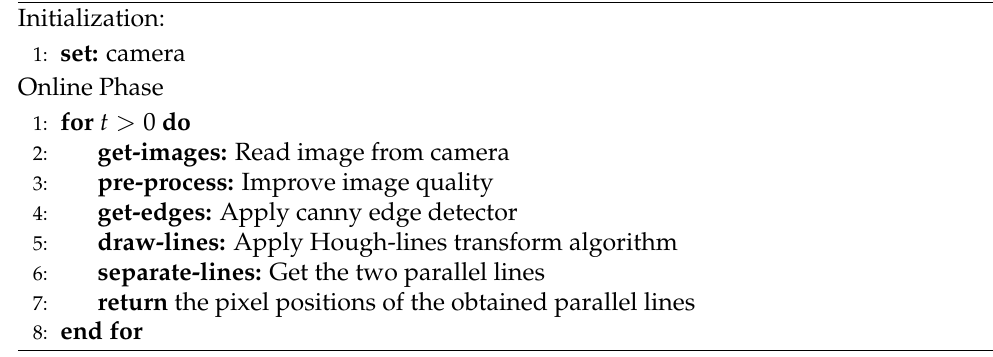
Algorithm 2 Monocular vision-based positioning